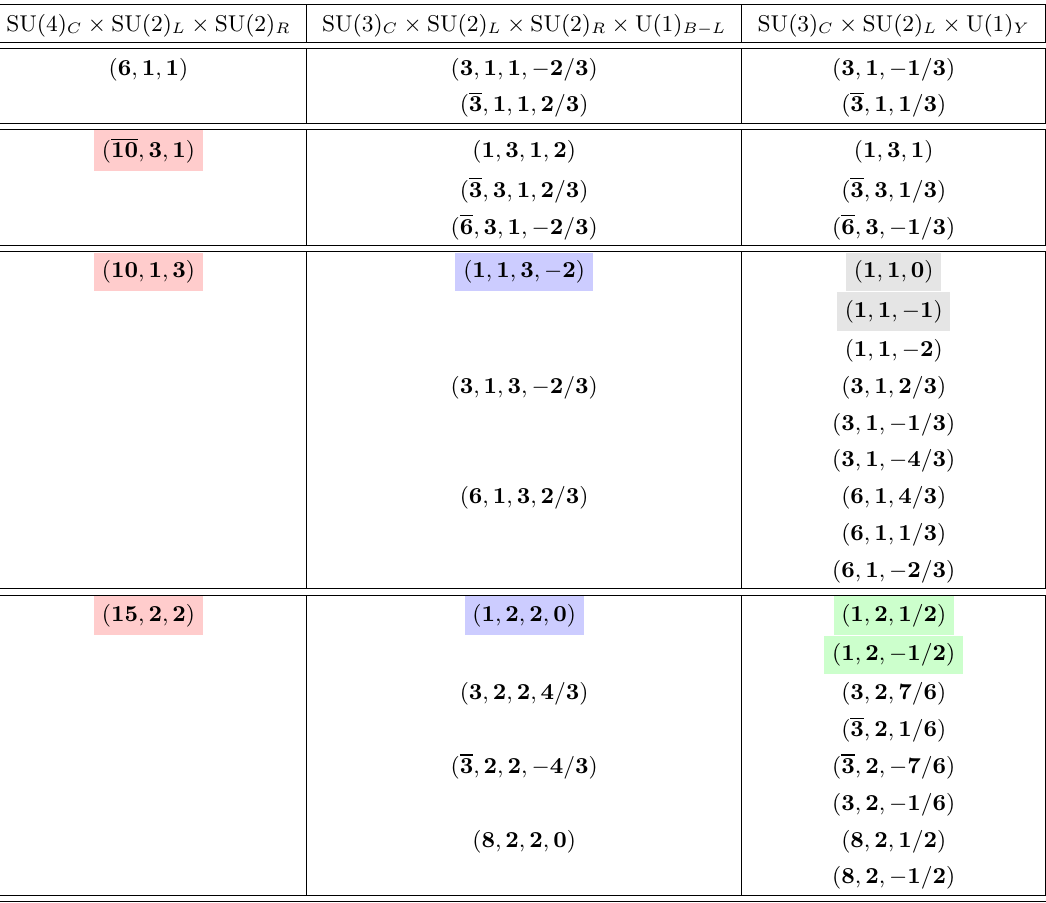
Table 11 . Decomposition of 126 -Higgs, which is a complex field. Multiplets highlighted in red, blue, and green contribute to the RGE running of the gauge coupling in the energy scale in between SO(10) and G 422 , G 422 and G 3221 , and G 3221 and G 321 , respectively. Multiplets highlighted in gray represent the Goldstone